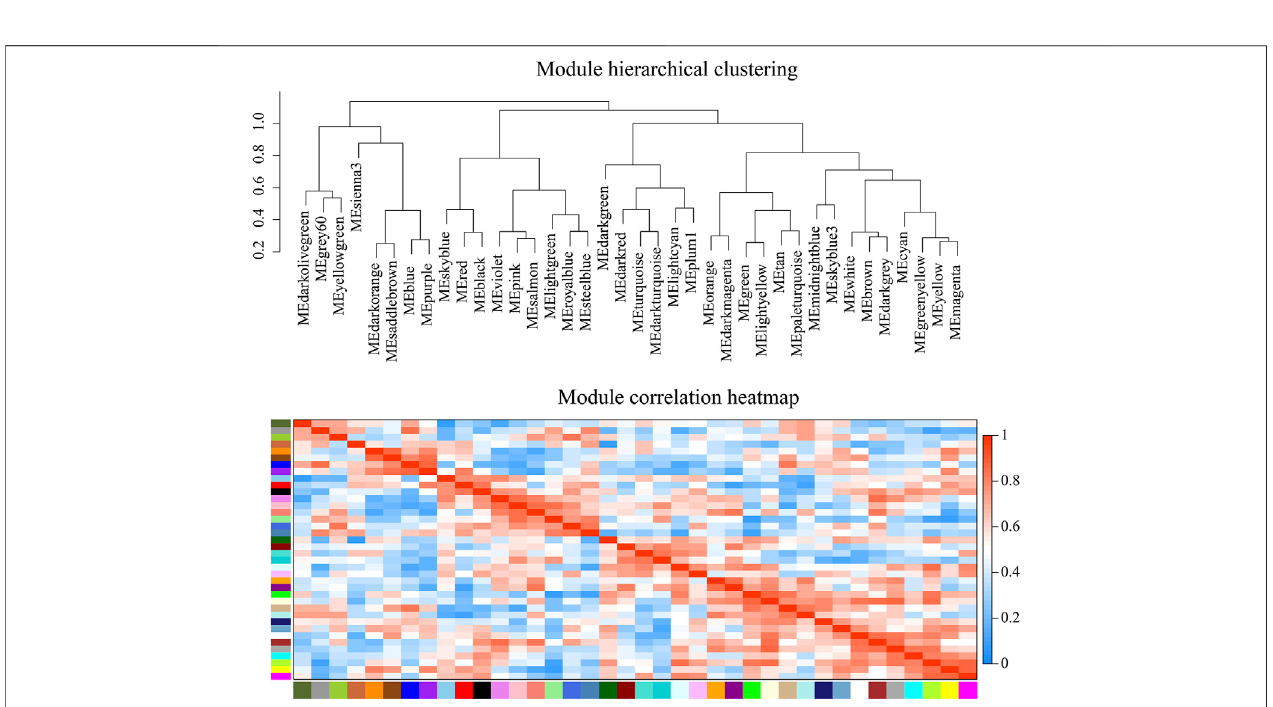
FIGURE 7 | Weighted gene co-expression network analysis (WGCNA) module hierarchical clustering. The value range of correlation is 0 – 1.